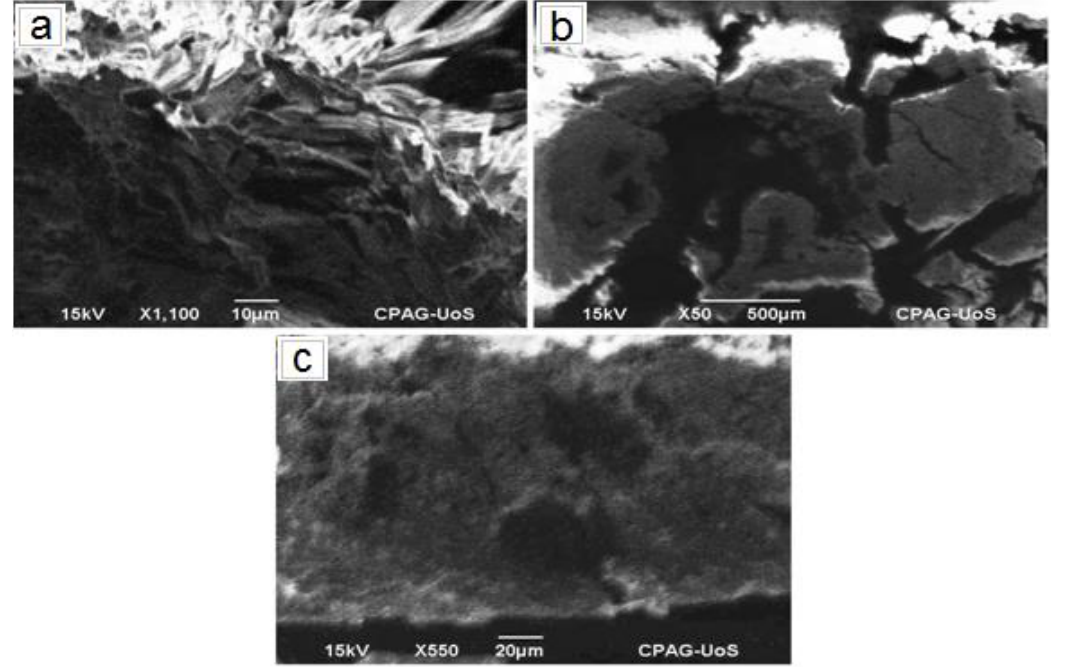
Figure S22: SEM images of monomer o -HON and its derived polymer P o HONPD, (a) o -HON, (b) P o HONPD at 500 µm (c) P o HONPD at 20